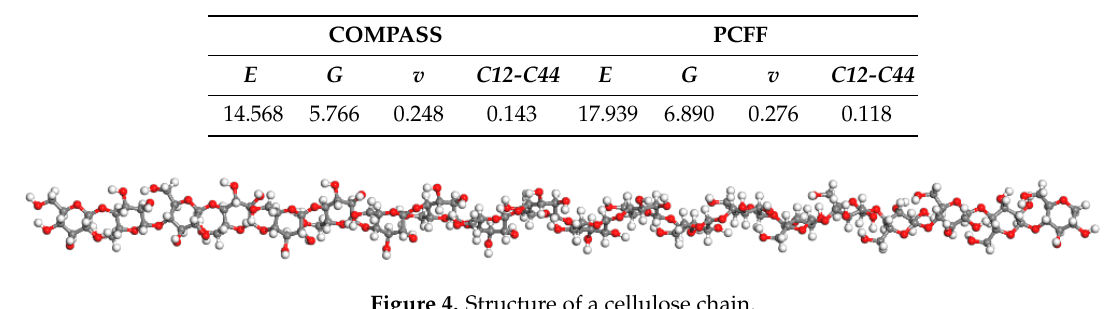
Table 1. Average values of E , G , v , and C12-C44 of properties in a steady state of the cellulose models using different force fields. Figure 4. Structure of a cellulose chain.